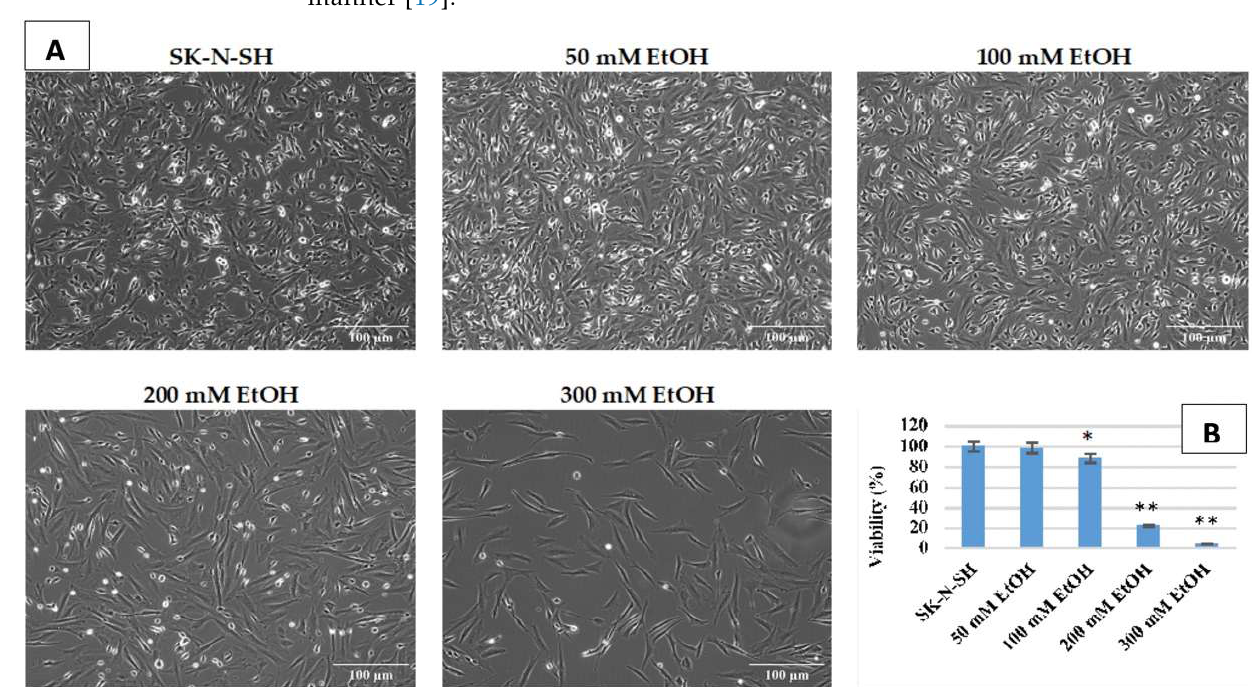
Figure 1. Phase contrast images, obtained using 10× objective, presenting the morphology ( A ) and viability ( B ) of SK-N-SH cells exposed at different ethanol concentrations ( p -value < 0.05 was considered statistically significant, * p < 0.05, ** p <